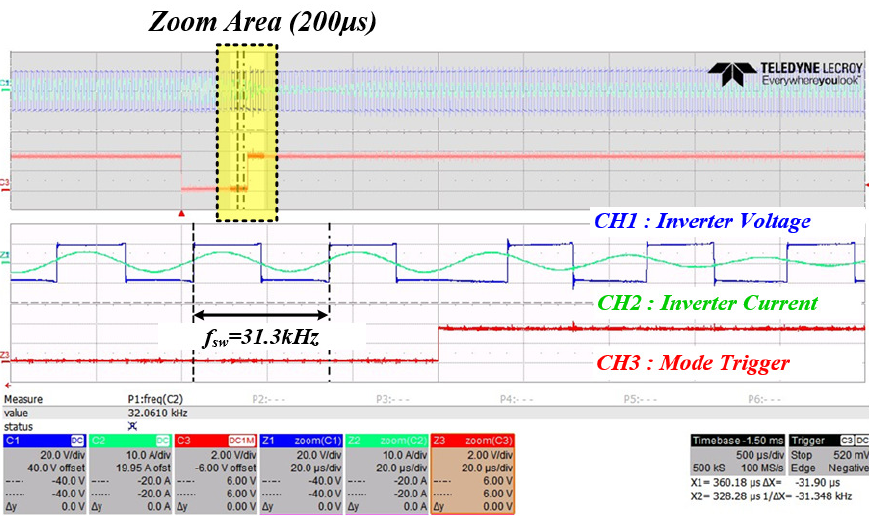
Figure 23. Inverter output waveform when mode 2 changes to mode 3 (CH1: inverter voltage (blue), CH2: inverter current (green), CH3: mode trigger (red)).